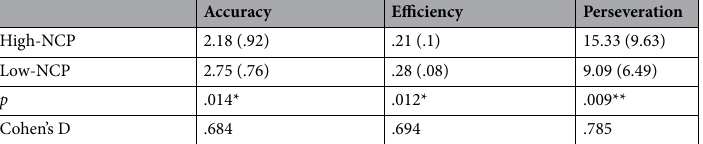
Table 2. Performance summary. Mean and standard deviation value of accuracy, efficiency, and perseveration errors by group. In all facets of executive functioning measures, the high-NCP group showed deficits compared to the low-NCP group. p < .05*; p <